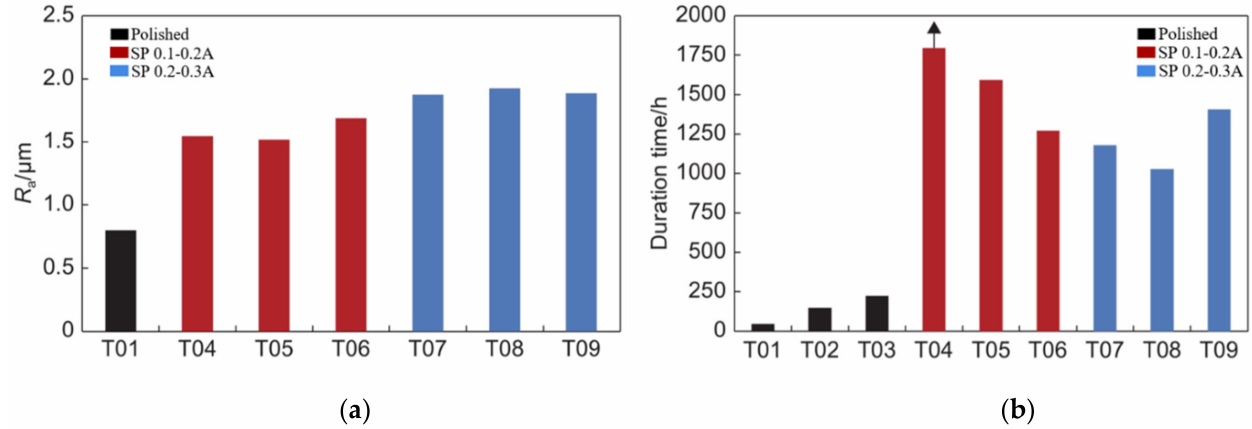
Figure 10. Surface roughness and duration of stress corrosion under different shot peening intensities. ( a ) Surface roughness; ( b ) stress corrosion cracking duration